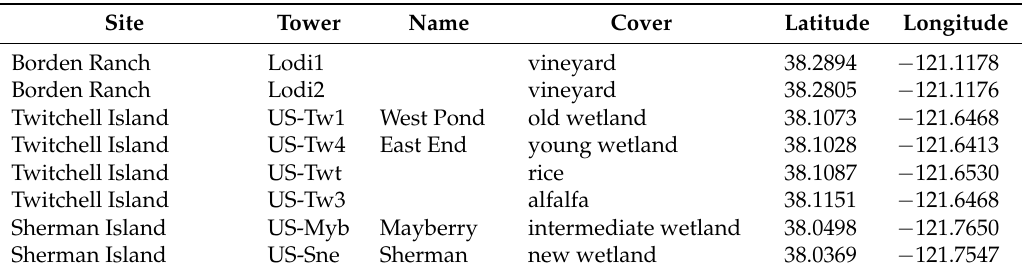
Table 1. Flux towers used in the